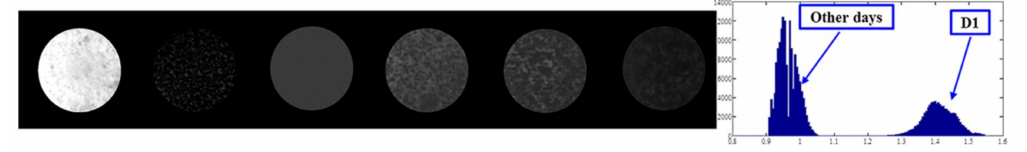
Figure 3. Band ratio image (460/446 nm) of A. flavus